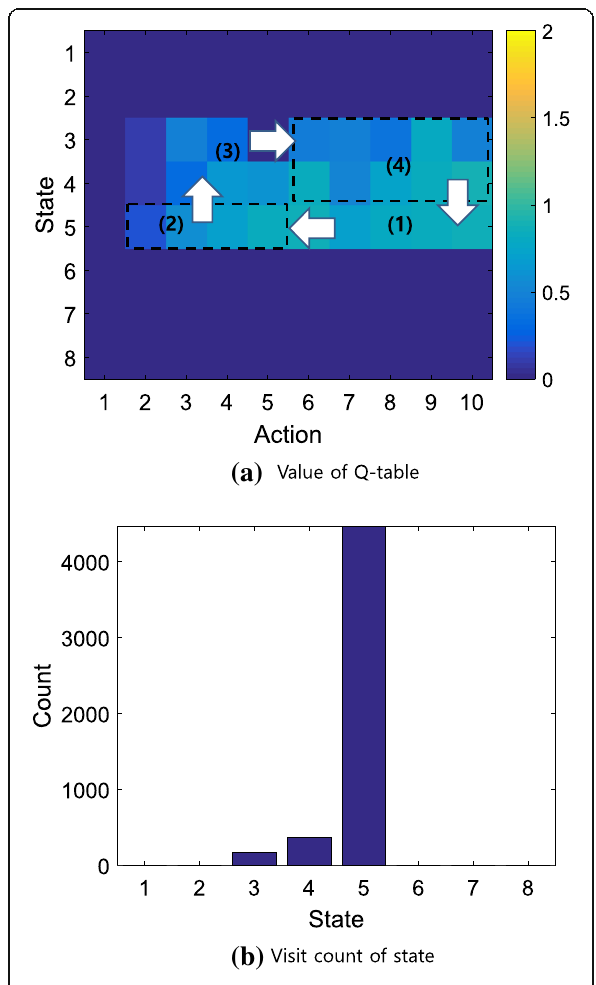
Fig. 13 The a Q-value of Q-table when DDR=90kbps, and b number of state visits. Similar to Figs. 9 and 10b, the Q-value of Q-table shows the channel movement of moderate DDR case. The visit count of a state is high in the state of low DRE and high CBG because the stable domain is in that